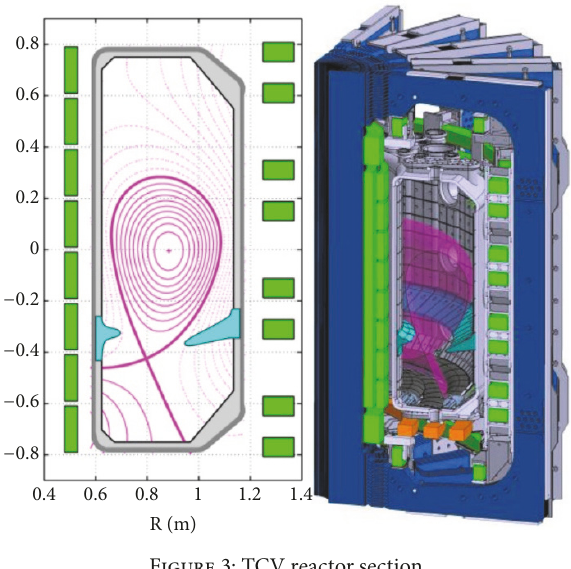
Figure 3: TCV reactor section.